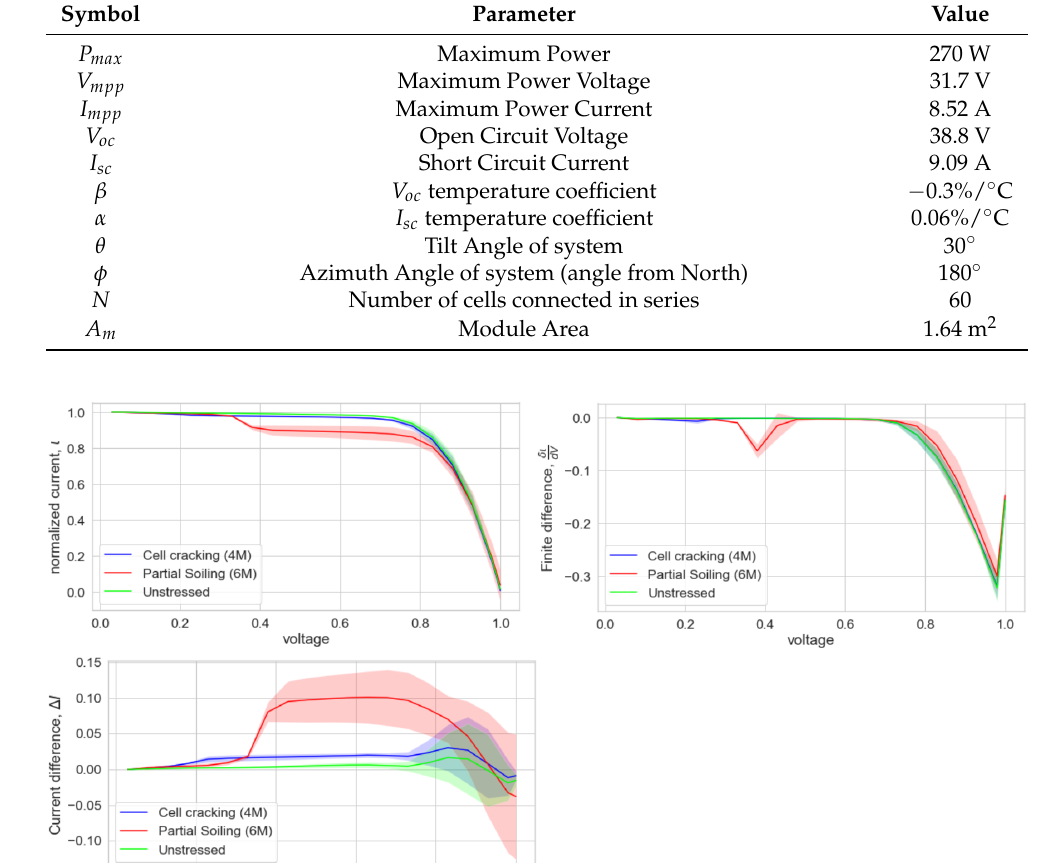
Table 1. Module specifications under standard test conditions of modules in the FSEC dataset. These parameters describe the real system, which is collect measurements; however, the simulations also use these parameter specifications to more accurately characterize the system.